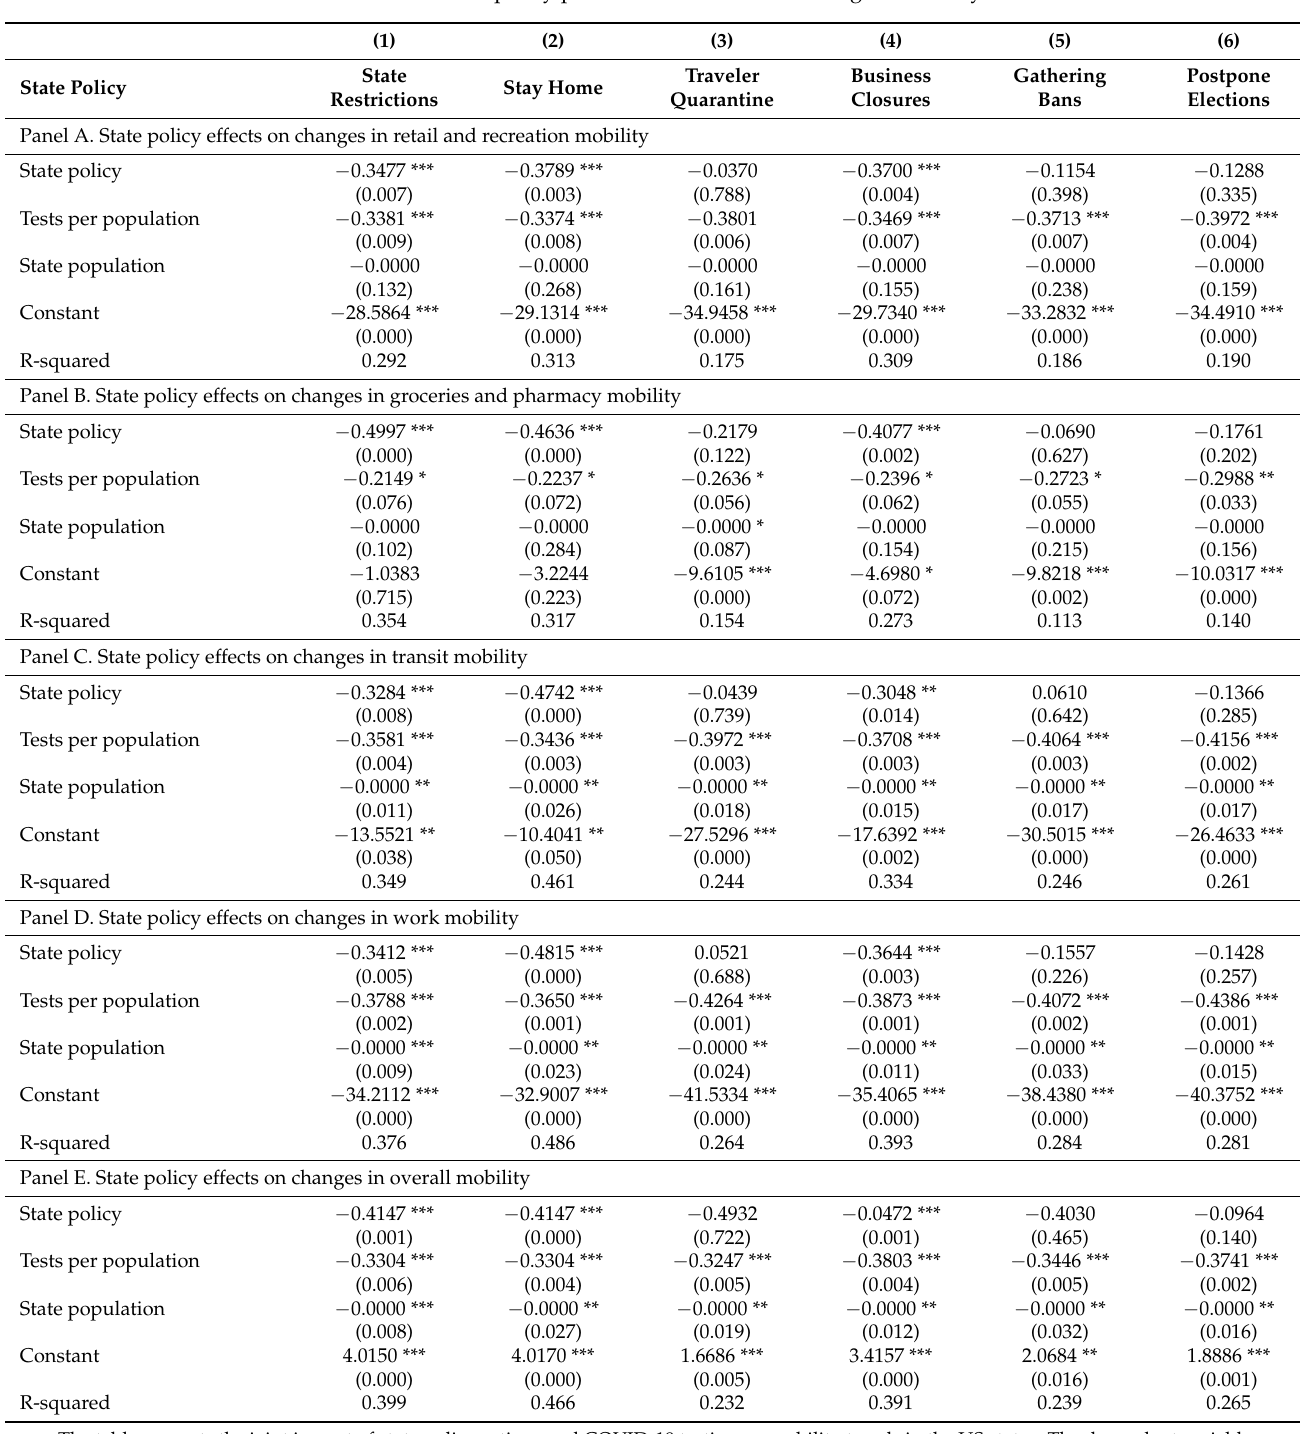
Table 3. Effects of state policy policies and COVID-19 testing on mobility